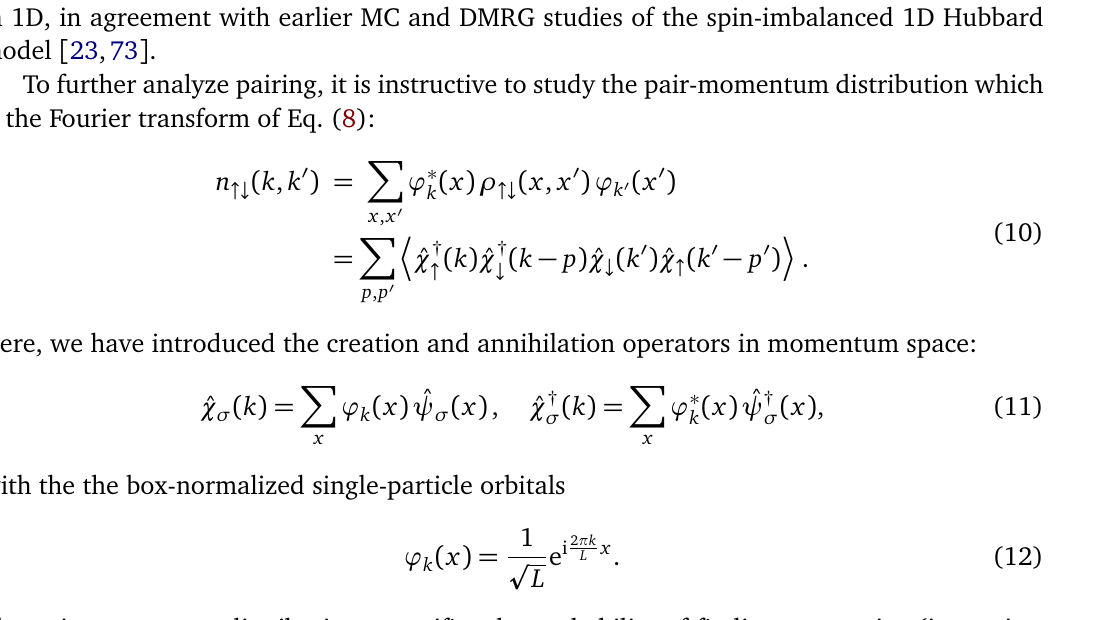
↑ − k ↓ | is found to be in excellent F F